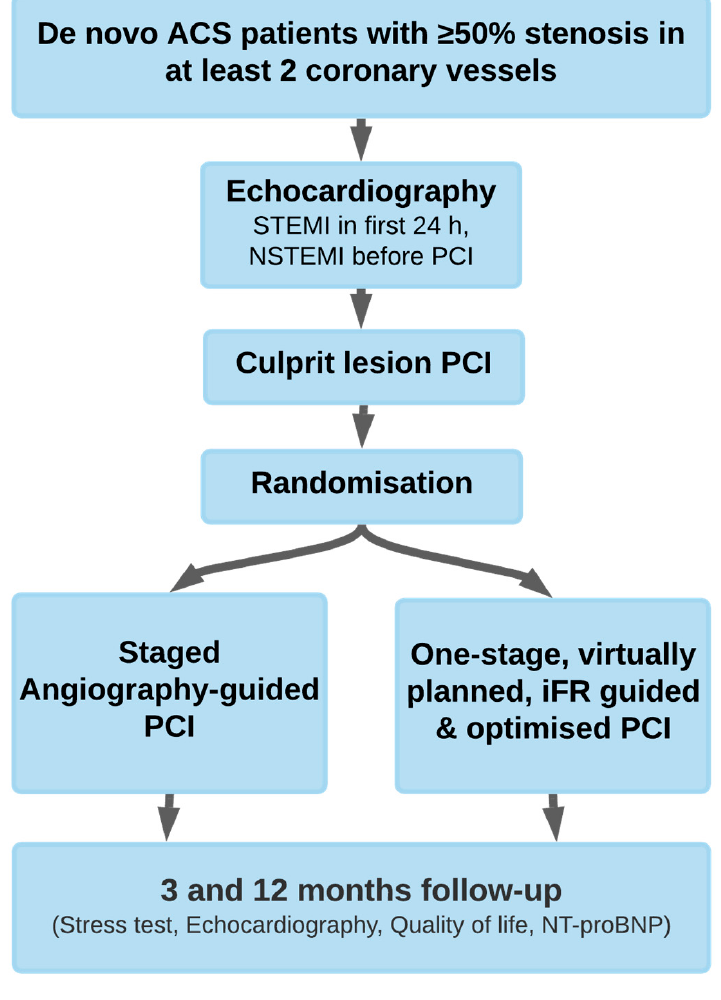
Figure 1. Trial design. ACS = Acute coronary syndrome; STEMI = ST-Elevation myocardial infarction; NSTEMI = non–ST-segment elevation myocardial Infarction; PCI = Percutaneous coronary intervention; iFR = instantaneous wave-free ratio; NT-proBNP = N-terminal pro-brain natriuretic peptide.